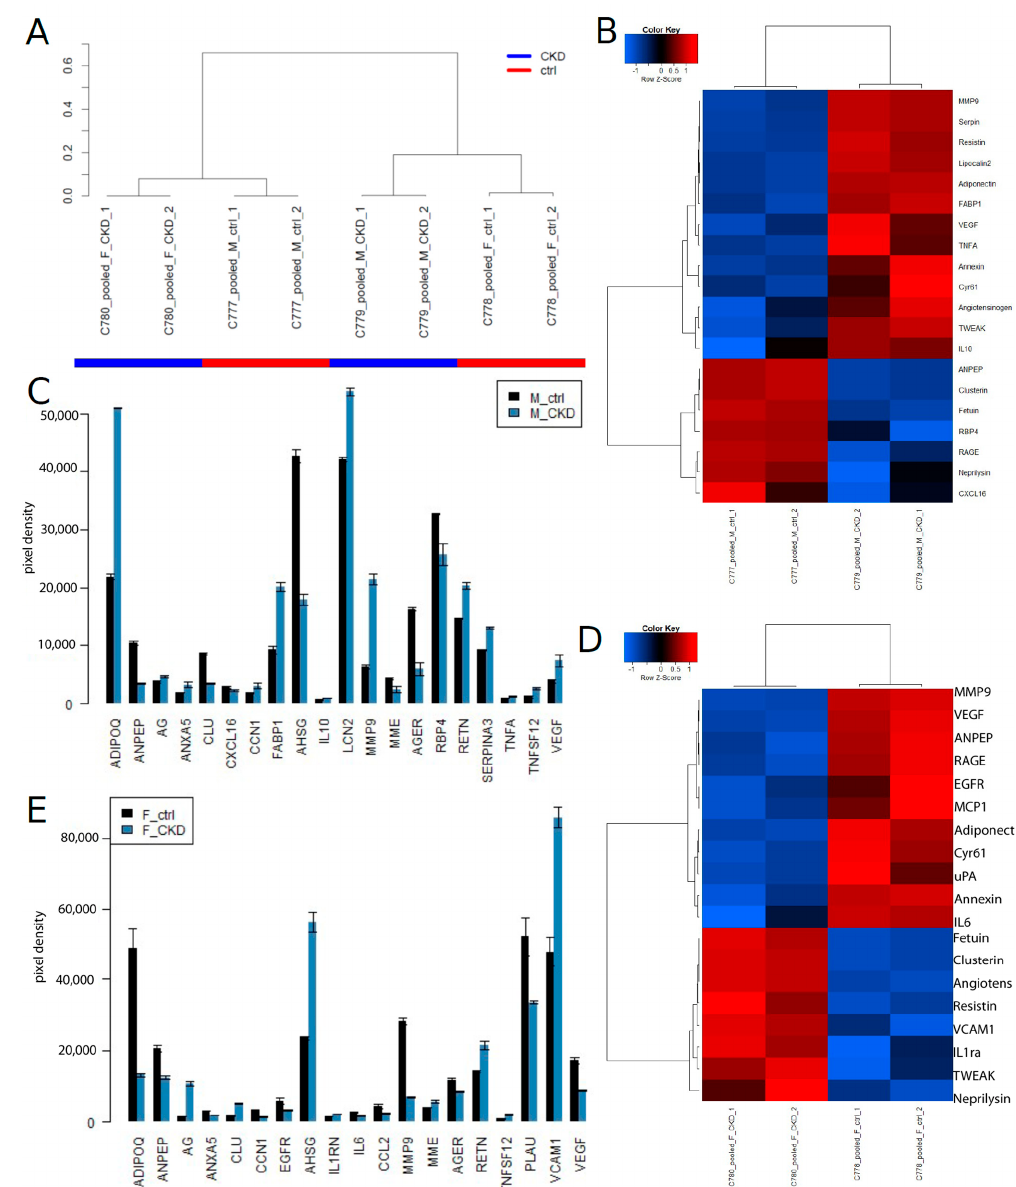
Figure 3. CKD biomarkers identified on the Human Kidney Biomarker Array in experiment series 2. ( A ) experiments cluster heterogeneously based on the global kidney cytokine expression. ( B ) Heatmap and ( C ) barplot of biomarkers in males (M) that were up ‐ regulated (up): ADIPOQ, AG, ANXA5, CCN1, FABP1, IL10, LCN2, MMP9, RETN, SERPINA3, TNFA, TNFSF12 and VEGF, and down ‐ regulated (down): AGER, AHSG, ANPEP, CLU, CXCL16, MME and RBP4. ( D ) Heatmap and ( E ) barplot of biomarkers in females (F) that were up ‐ regulated (up): AG, AHSG, CLU, IL1RN, MME, RETN, TNFSF12 and VCAM1, and down ‐ regulated (down): ADIPOQ, AGER, ANPEP, ANXA5, CCL2, CCN1, EGFR, IL6, MMP9, PLAU and VEGF.